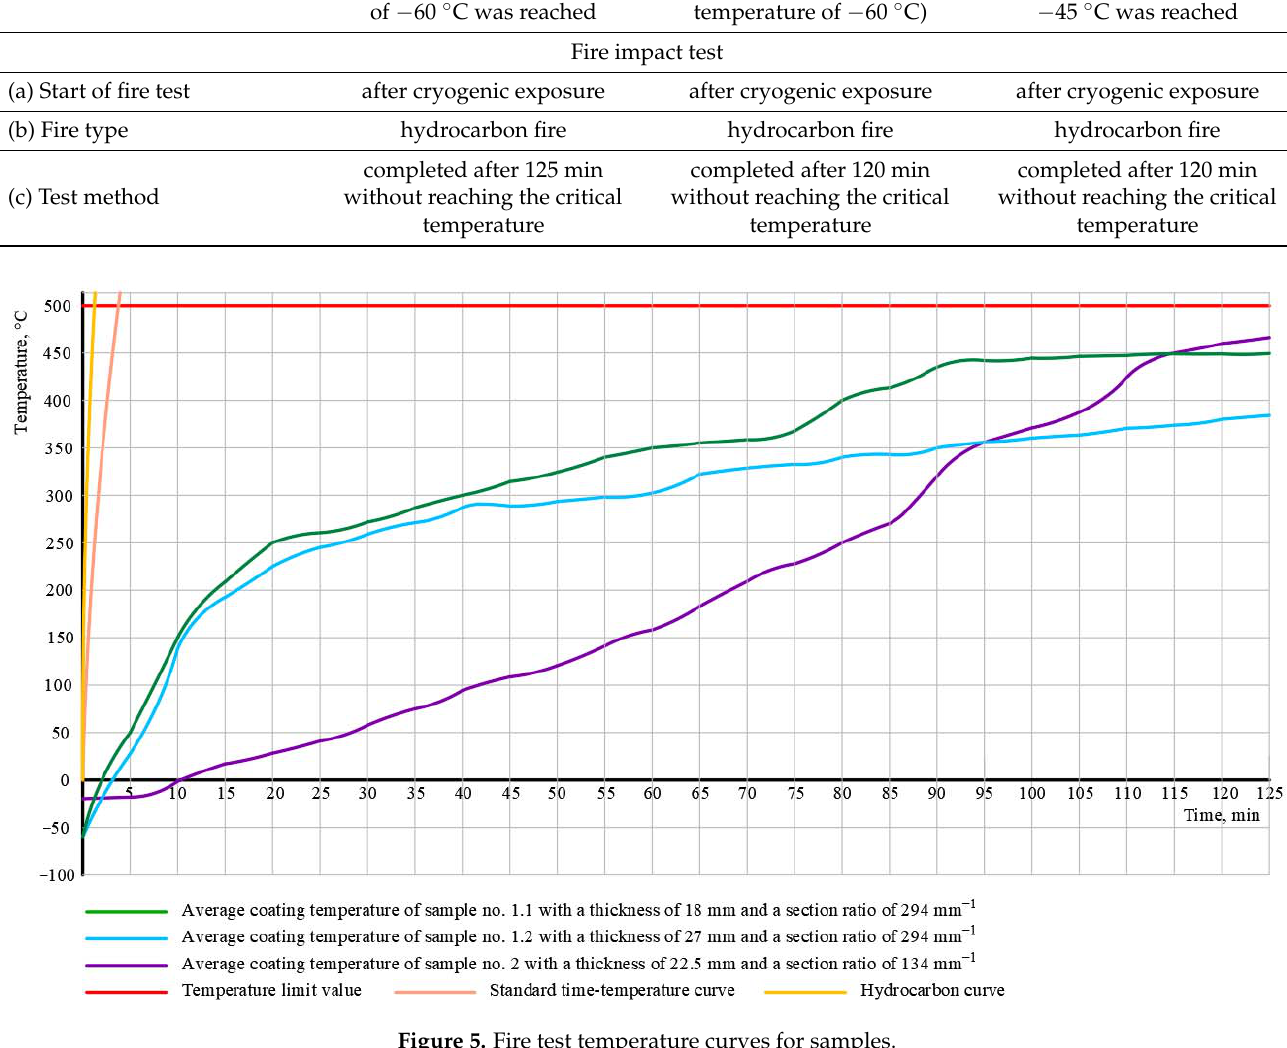
Figure 5. Fire test temperature curves for samples.